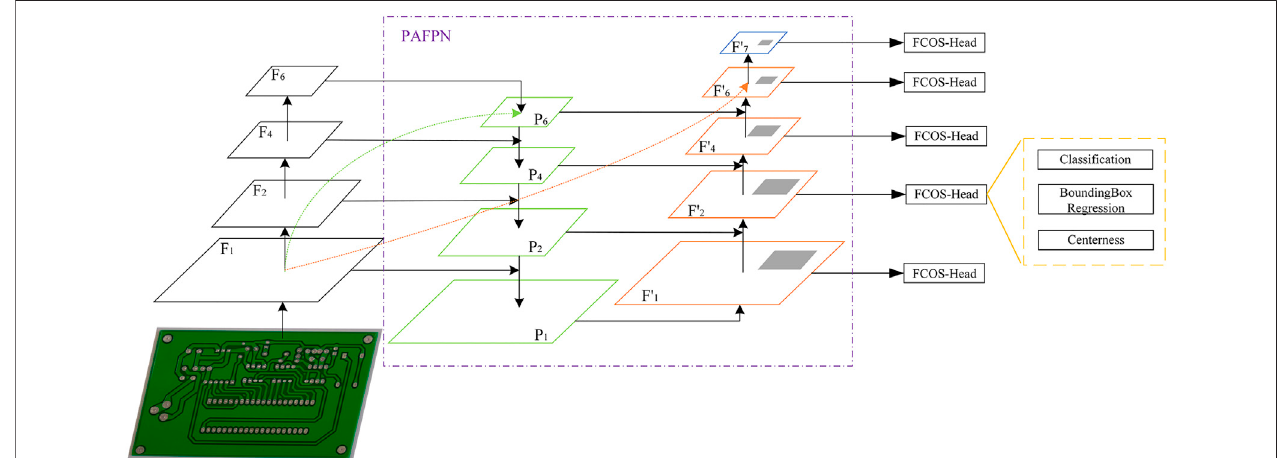
FIGURE 5 | Schematic diagram of PAFPN.